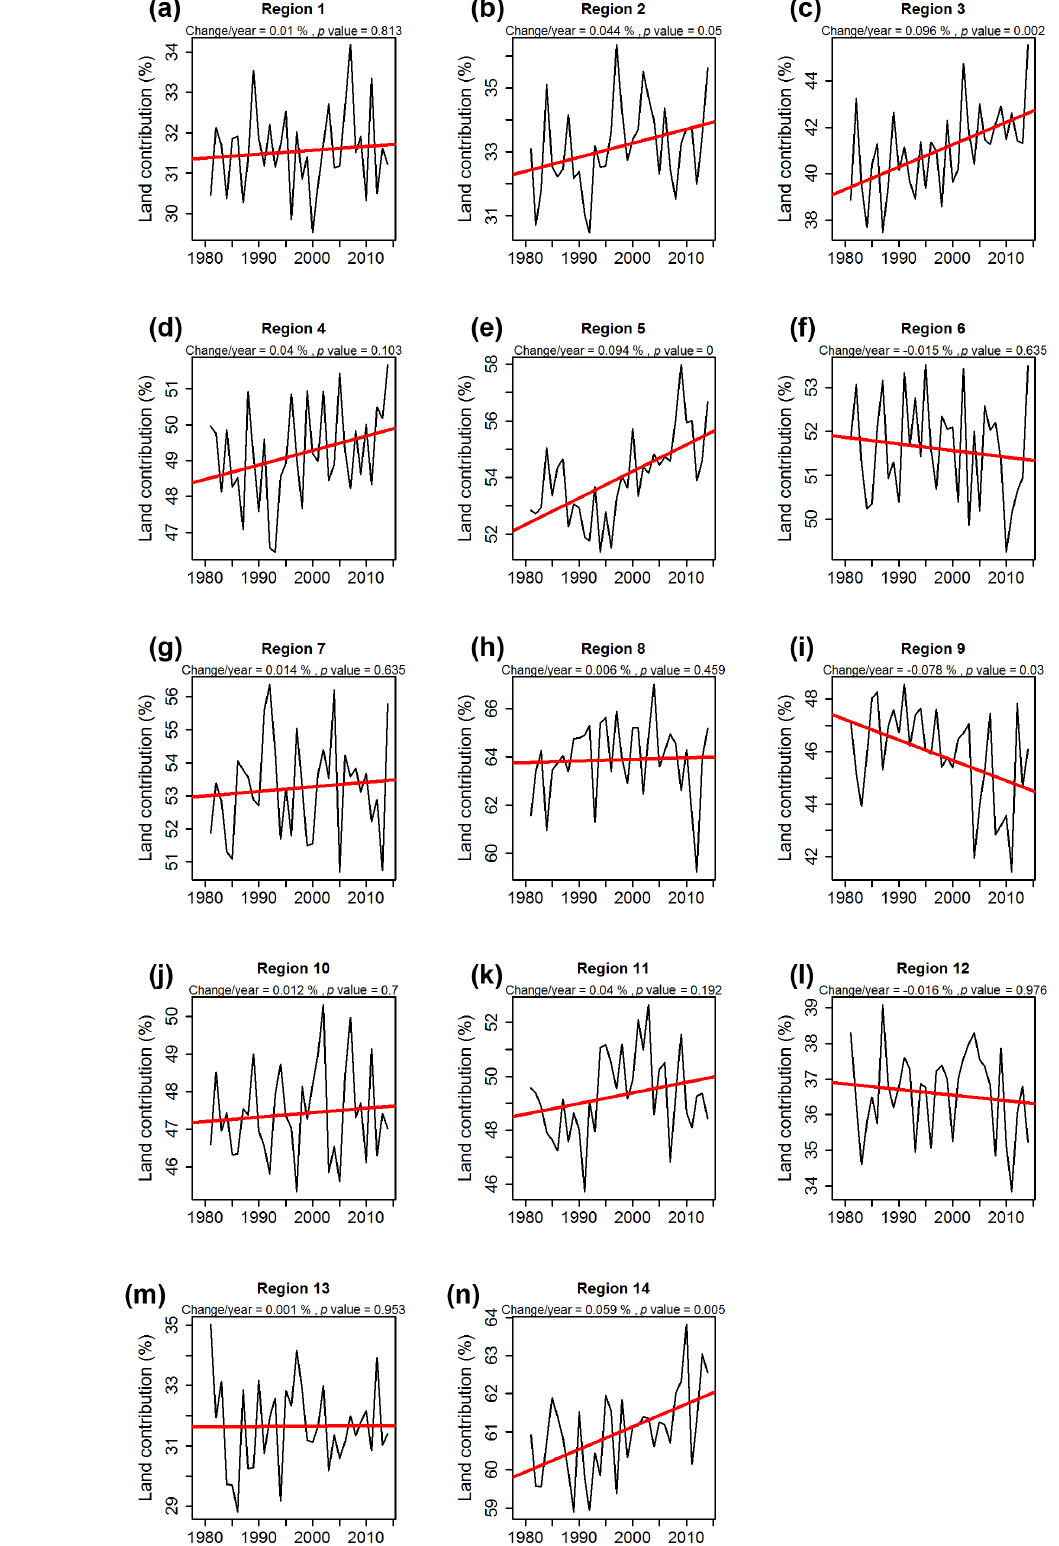
Figure 10. Evolution of the land contribution to annual precipitation (%) in the different target regions.